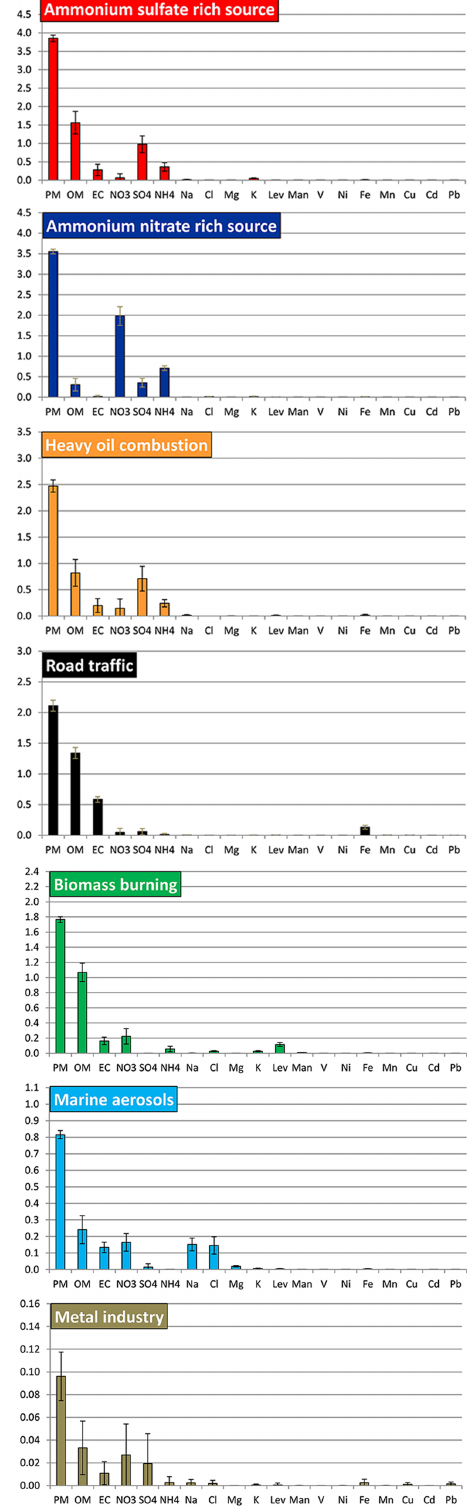
Figure 2. Contribution (µgm − 3 ) of the chemical species to each source (mean ± standard deviation of the bootstrap results, n = 100). Lev: levoglucosan, Man: